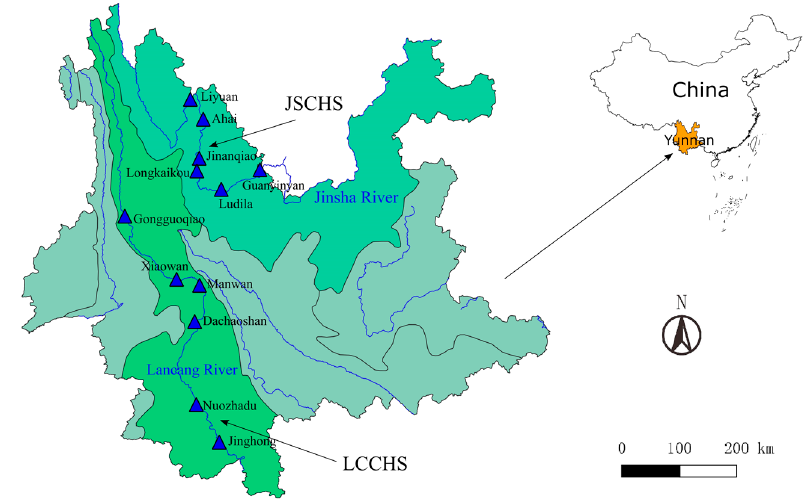
Figure 1. Location of Yunnan and hydropower plants of Lancang cascaded hydropower system (LCCHS) and Jinsha cascaded hydropower system (JSCHS).